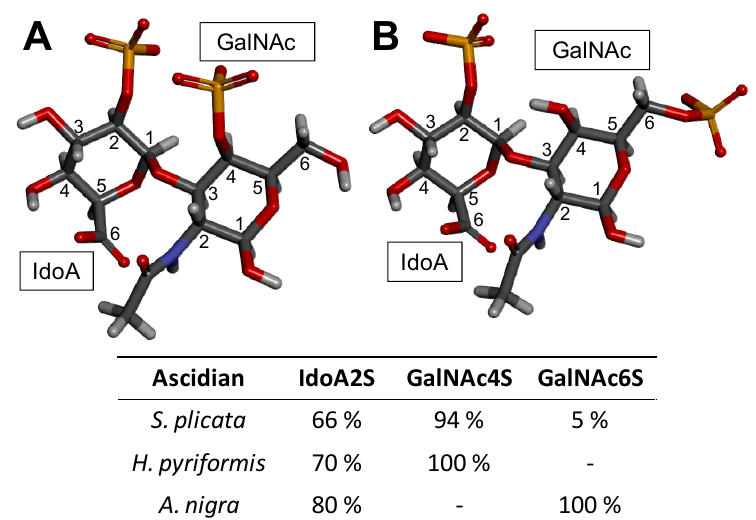
Figure 5. Representative disaccharide units, ( A ) IdoA2S( α 1 − 3)GalNAc4S and ( B ) IdoA2S( α 1 − 3)GalNAc6S, of the DS backbones from three ascidian species in their 3D stick models. These ascidian DS are highly sulfated at the C2 position of the α -L-IdoA units but differ in the pattern of sulfation at the β - D -GalNAc units. ( A ) In the species S. plicata and H. pyriformis the GalNAc moieties are heavily 4- O -sulfated, ( B ) whereas in A. nigra , they are 6- O -sulfated. Percentage of sulfation/site/species is shown in the table. Hydrogens, carbons, oxygens and nitrogens are respectively represented in light grey, dark grey, red and blue. Carbon atoms are numbered according to their positions in the ring. Monosaccharides are indicated accordingly. Model created by the online AMBER/GLYCAM-based carbohydrate builder [40].